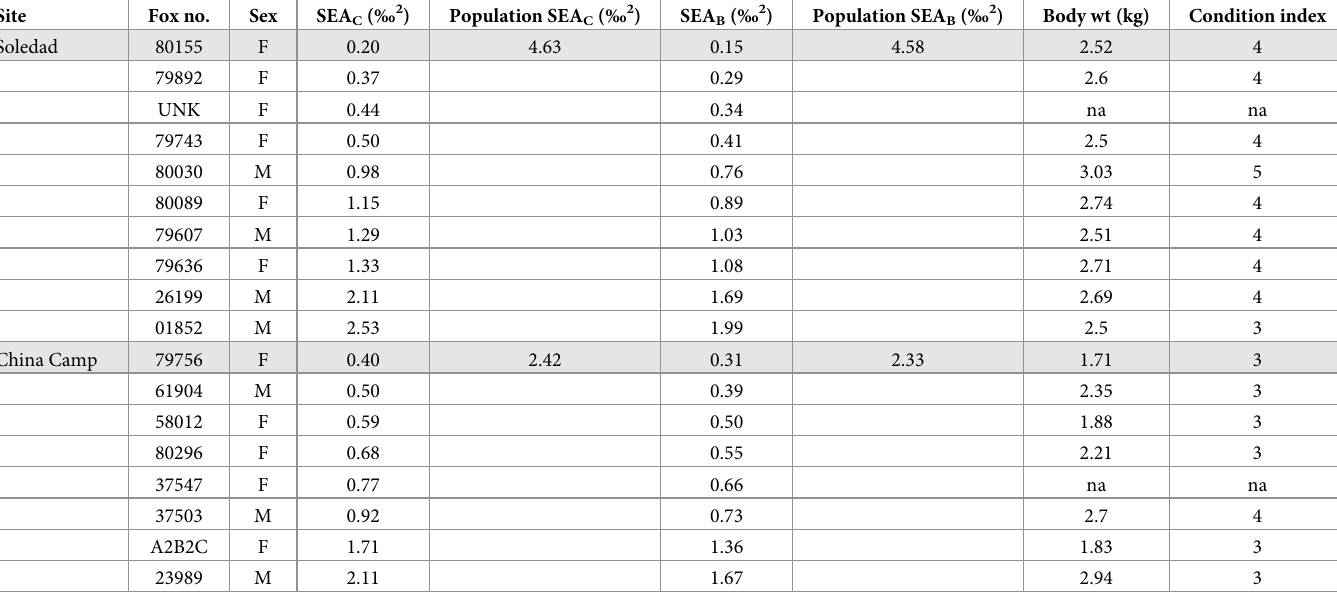
SEA values of individuals and populations of island fox trapped in December 2018 from Soledad and China Camp beach sites together with body weight and conditon of foxes from each site. Analysis used the most proximal eight segments from each sampled whisker. na = not available. separately for males and females. Females weighed on average ~27% more at Soledad than at China Camp ( p < 0.001, t = 2.992, df = 7, Student’s test, Fig 7A), but there was no difference in mean body weight for males between sites ( p = 0.786, t = 0.082, df = 5). There was a significant